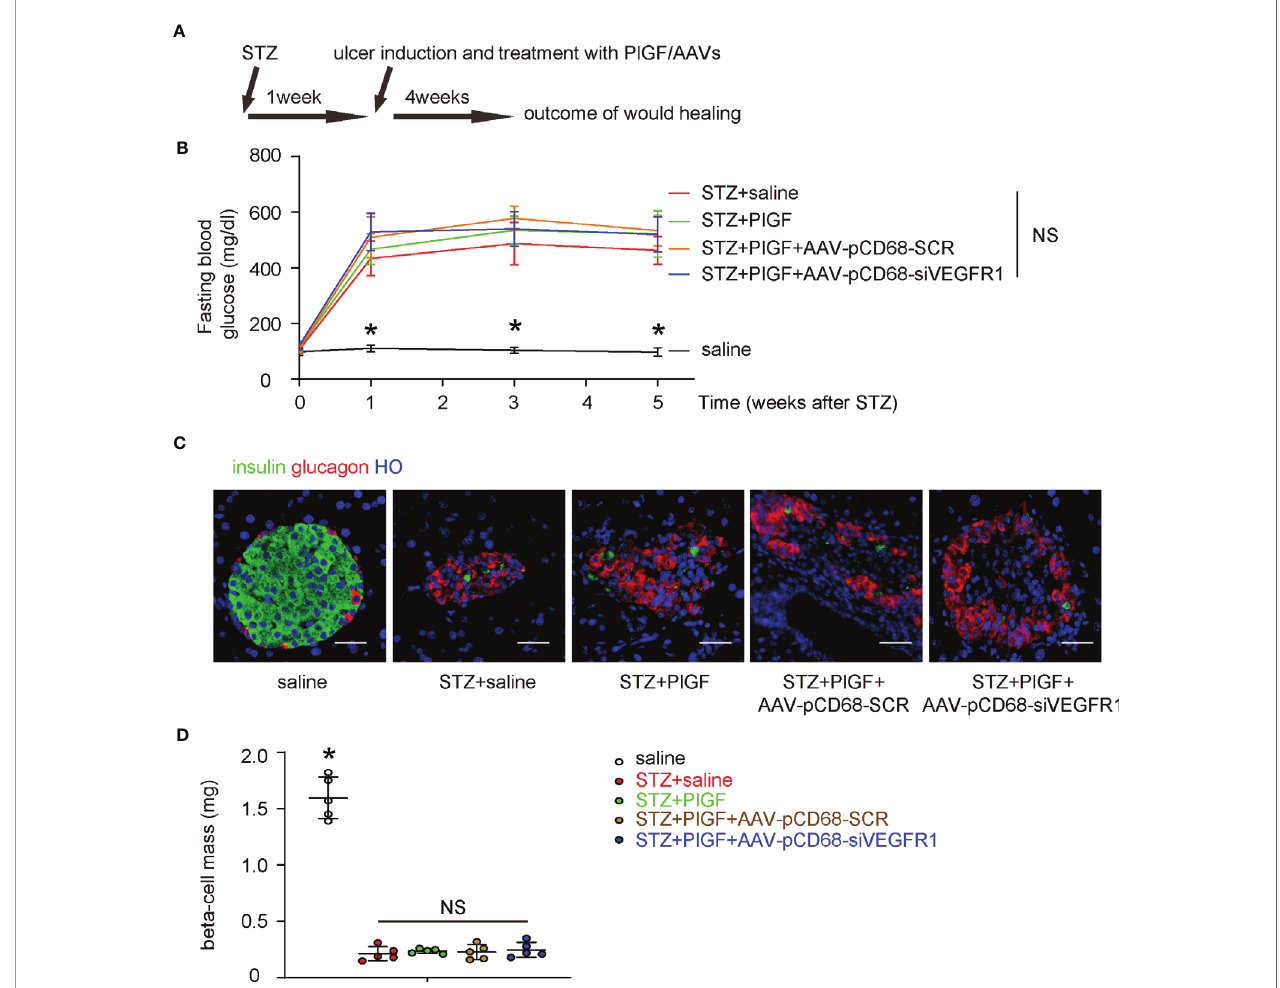
FIGURE 4 | PlGF with/without macrophage-depletion of VEGFR1 does not affect diabetes. (A) Schematic of a mouse model for DFD, in which C56/BL6 mice received STZ to induce diabetes and then a surgical ulcer at dorsal midline after one week. At the time of surgical ulcer induction, PlGF or saline was orthotopically injected biweekly while AAVs were given locally only once, immediately after ulcer induction. In another 4 weeks, the mice were sacri fi ced and analyzed. (B) Fasting blood glucose. (C) Representative immuno fl uorescent images for glucagon and insulin in mouse pancreas. (D) Beta-cell mass at sacri fi ce. *p < 0.05. NS, non- signi fi cant. Scale bars are 20